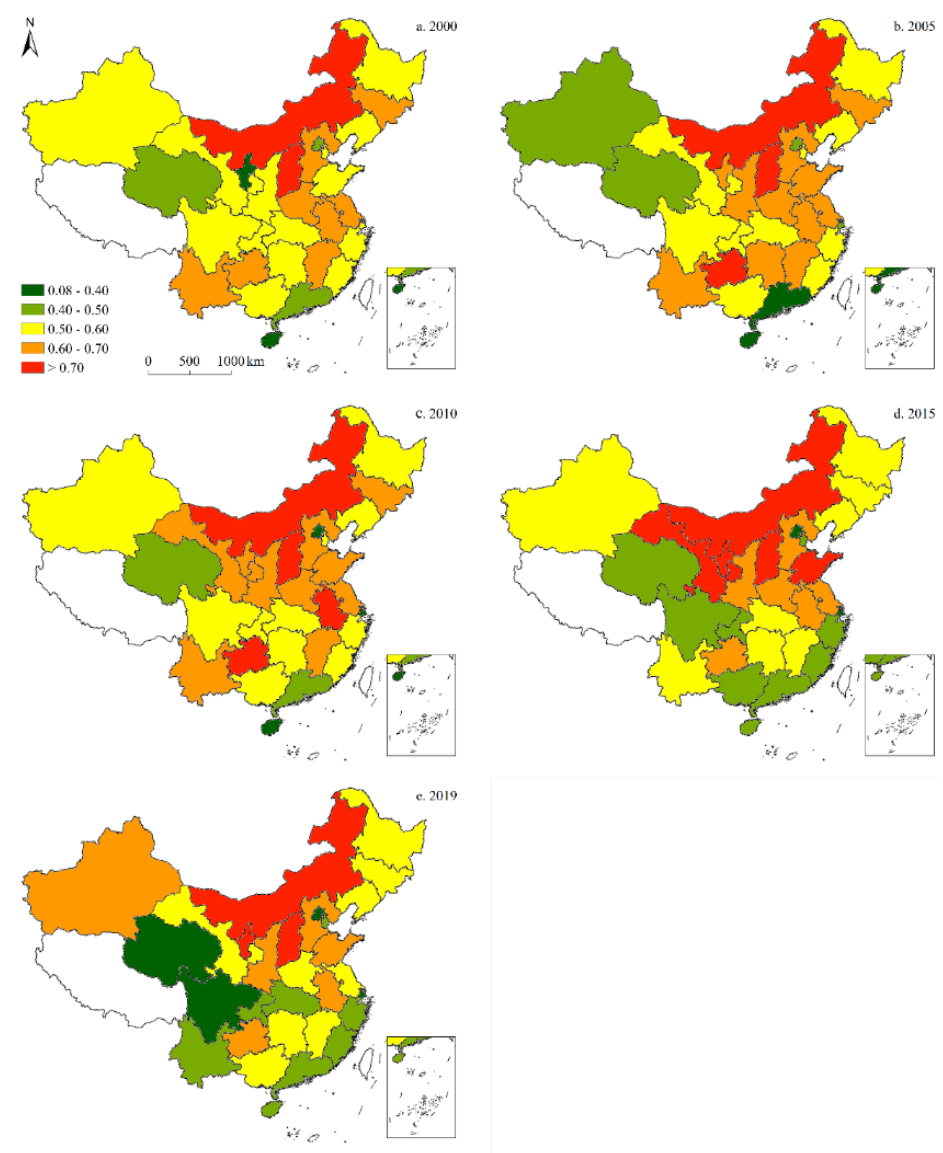
Figure 3. Spatiotemporal distribution of provincial-level coal consumption in China (five-time sec- tions).